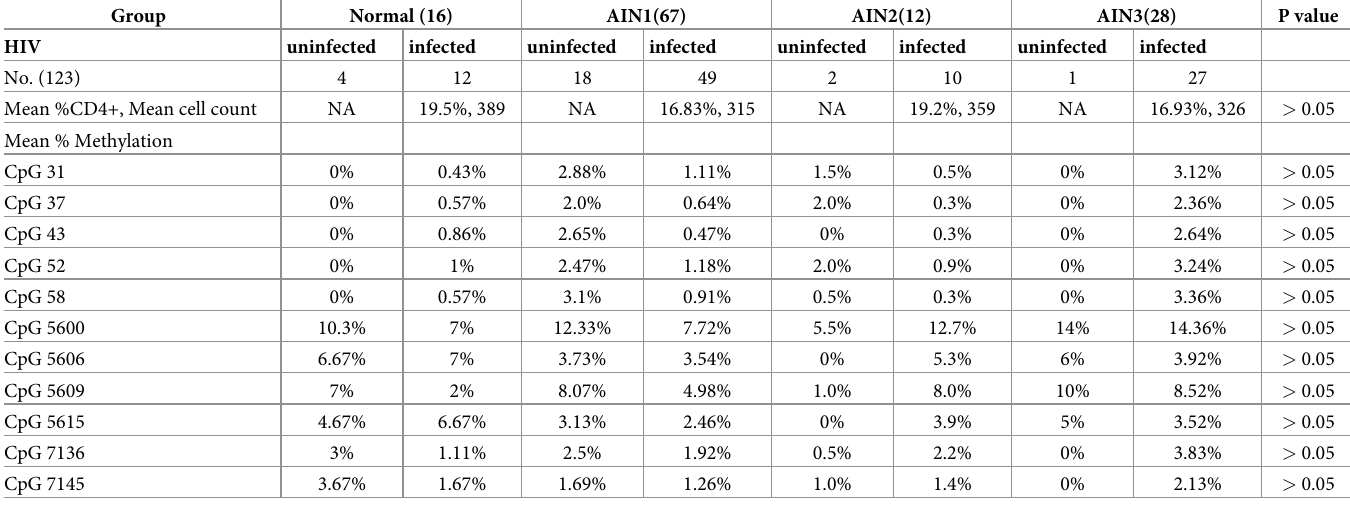
Table 3. Mean HPV16 gene methylation level of each CpG and the percentual CD4 count between HIV-infected and HIV-uninfected patients.